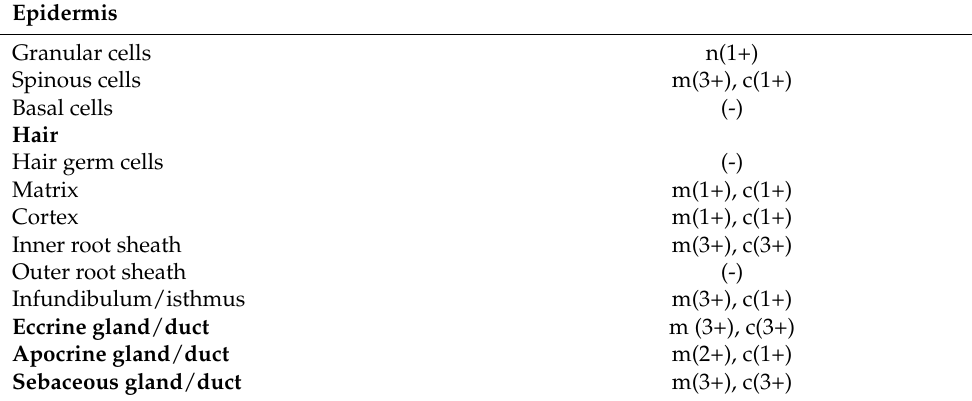
Table 2. Trop2 expression in normal skin and